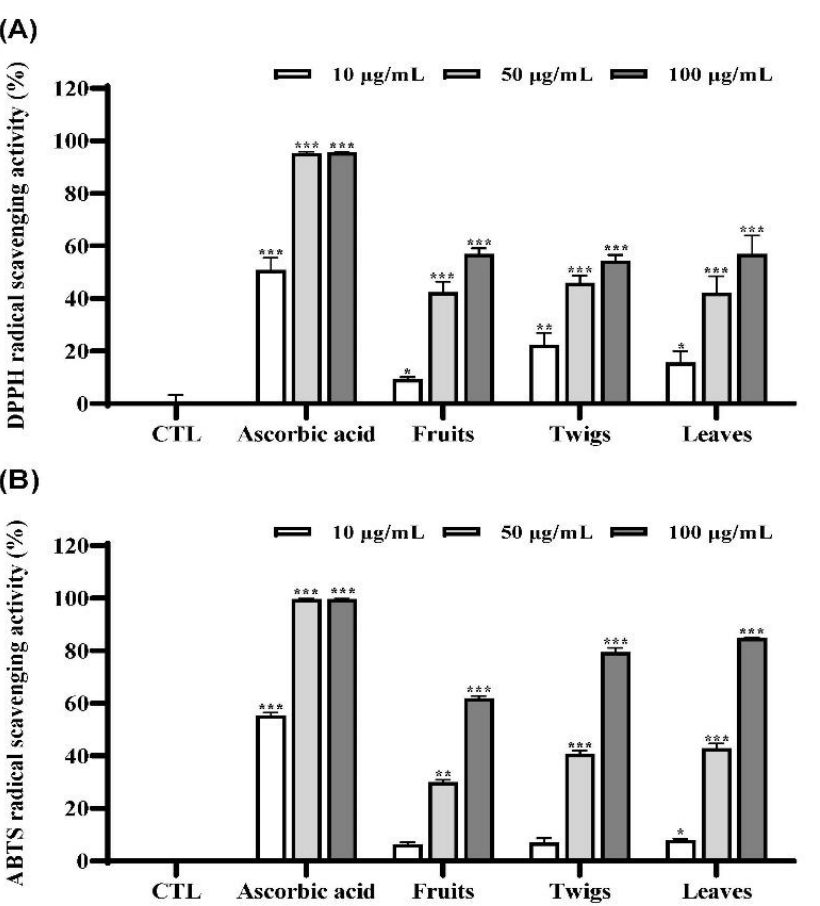
Figure 1. Effects of the extracts of I. rotunda fruits, twigs, and leaves on DPPH ( A ) and ABTS ( B ) radical scavenging assays. The data are expressed as the mean ± SD ( n = 3) of three individual experiments. * p < 0.05, ** p < 0.01, and *** p < 0.001, compared with control (CTL) (blank sample). After the first experiments, DPPH and ABTS assays were also performed using I. rotunda twigs (extracted with 0%, 20%, 40%, 60%, 80%, and 100% EtOH) at different concentrations. The 80% EtOH twig extract showed a higher radical scavenging activity (69.0% inhibition) in DPPH assay than other twig extracts at the same concentration of 50 µ g/mL (Figure S2A). In the ABTS assay, the 80% EtOH (71.9%) extract showed similar activity to the 20% EtOH (83.1%) extract at 50 µ g/mL (Figure S2B). The obtained yield using 80% EtOH (24.4%) was higher than that using 20% EtOH (23.8%). Thus, 80%